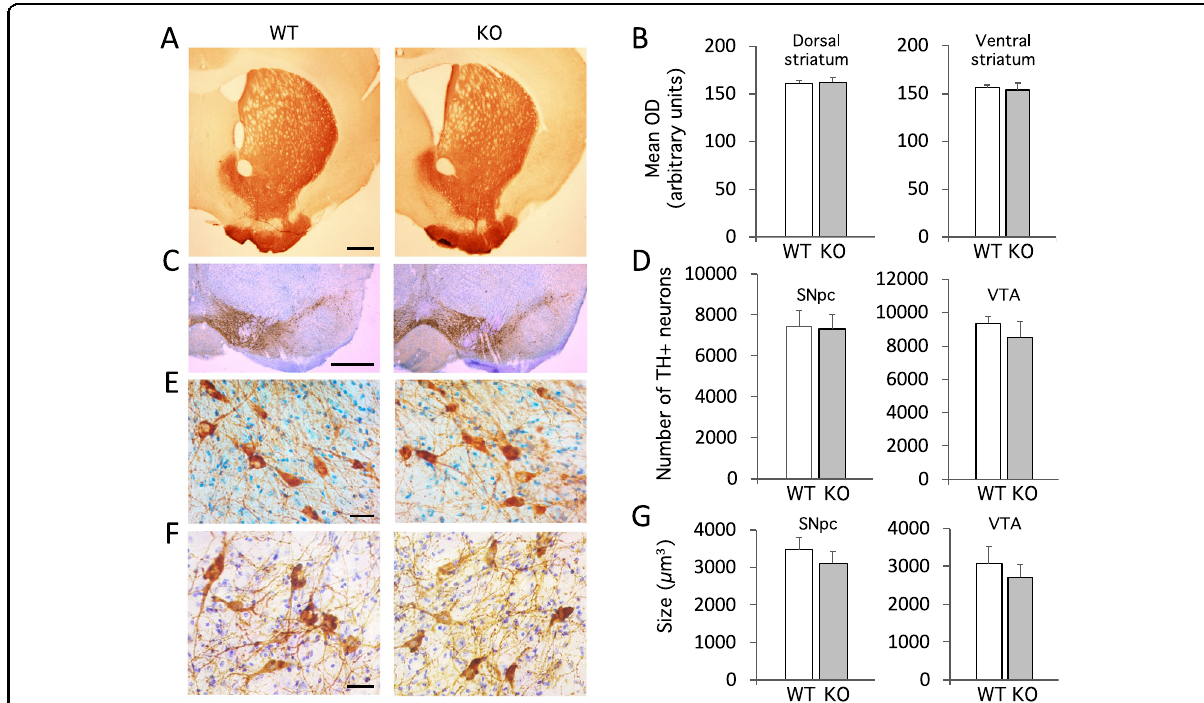
Fig. 3 Cell body size and number of dopaminergic neurons in the nigrostriatal and mesolimbic systems from male zdhhc15 -KO mice. A Representative images of striatal sections immunostained using an anti-TH antibody from WT and zdhhc15 -KO mice. Scale bar: 500 μ m. B There were no signi fi cant differences between WT and KO mice in the density of projections of dopaminergic neurons to the dorsal or ventral striatum. Measurements of the mean density were performed using ImageJ in pictures at three different Bregma levels in the striatum. C Representative images of coronal sections of mesencephalon from WT and zdhhc15 -KO mice after TH immunostaining. Scale bar: 50 μ m. D Quanti fi cation of the number of TH + neurons in the SNpc and VTA from zdhhc15 -KO mice and controls. There were no signi fi cant differences between WT and KO mice in the number of dopaminergic neurons in the SNpc or the VTA quanti fi ed by stereological measurements. E , F Representative images showing dopaminergic neurons stained against TH in the SNpc ( E ) and VTA ( F ) of WT and KO mice. Scale bar: 10 μ m. G There were no signi fi cant differences between WT and KO mice in the size of the cell body of dopaminergic neurons in the SNpc. Quantitation was performed by stereology using the rotator method ( n = 6 mice per genotype, student t -test, p >